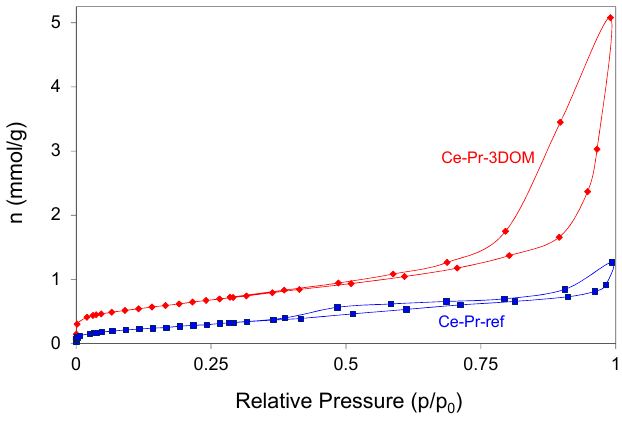
Figure 7. N 2 adsorption ‐ desorption isotherms of the fresh catalysts.